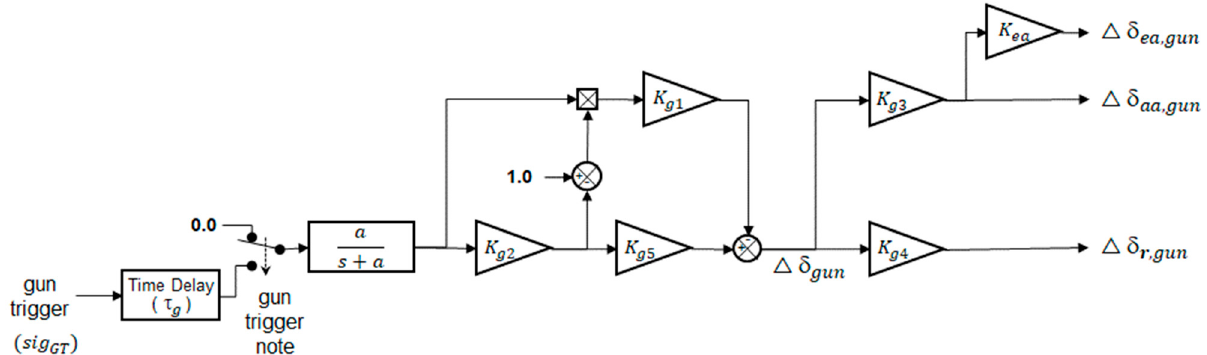
Figure 3. Control structure of desired dynamics: ( a ) longitudinal axis; ( b ) lateral axis; ( c ) directional axis [20,21].